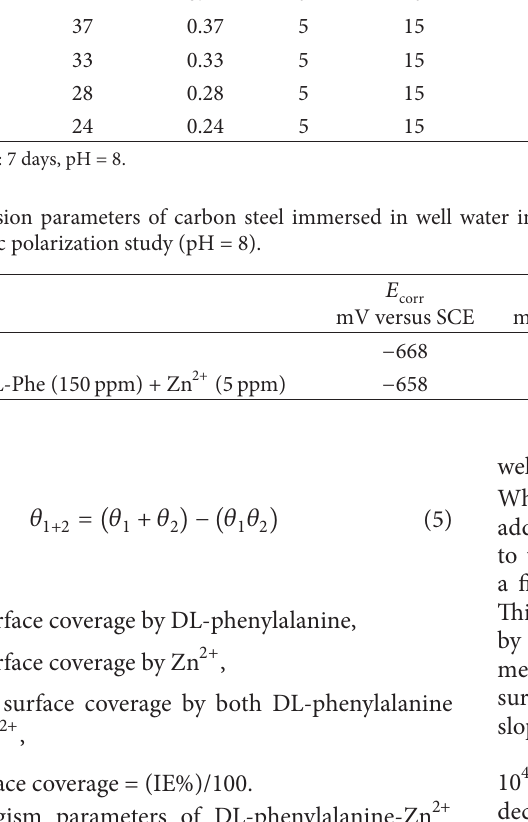
(5 ppm) system, when carbon steel is 2+